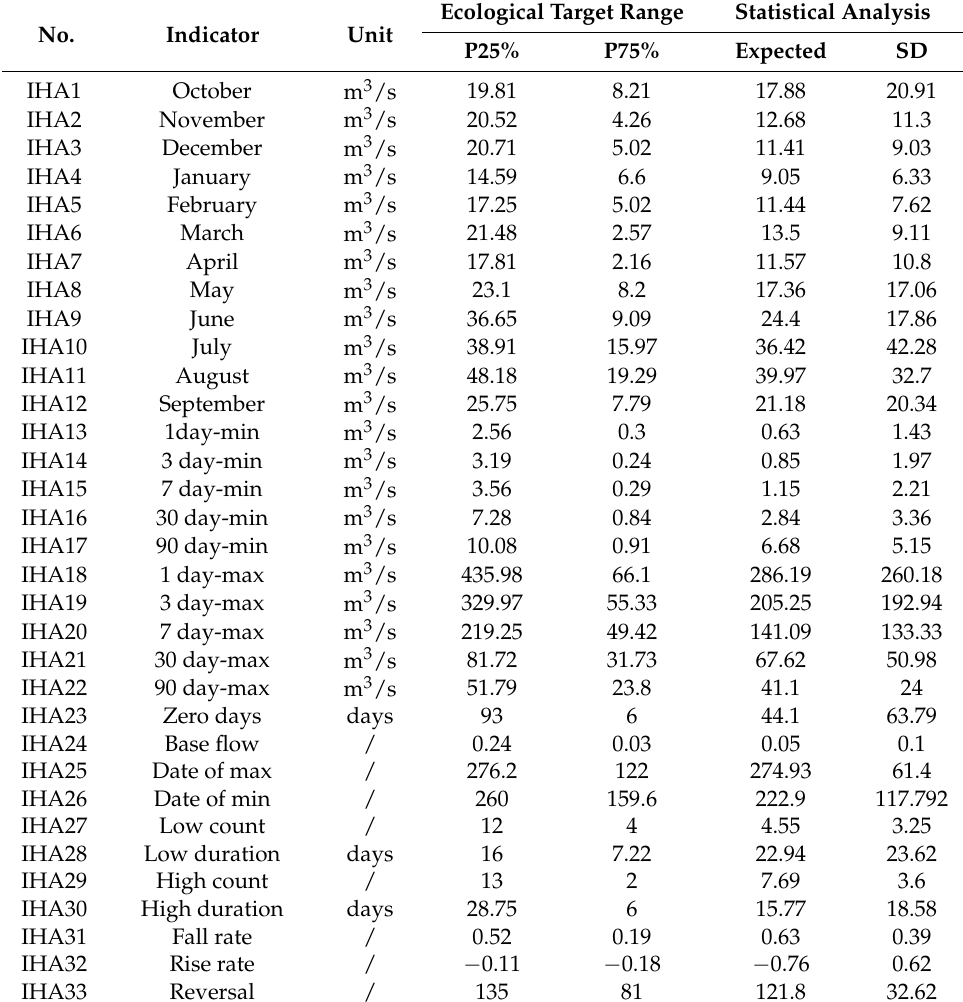
Table 1. Ecological target ranges and statistical analysis of eco-hydrologic